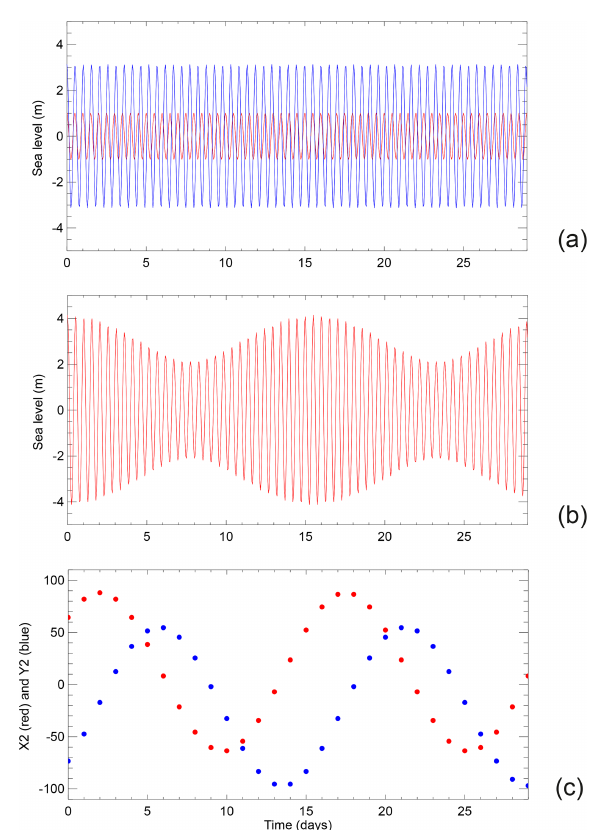
Figure 5. (a) A schematic example of the variation of M2 (blue) and S2 (red) at Liverpool over a month, (b) M2 and S2 in combi- nation and (c) the corresponding time series of daily values of X2 (red) and Y2 (blue).